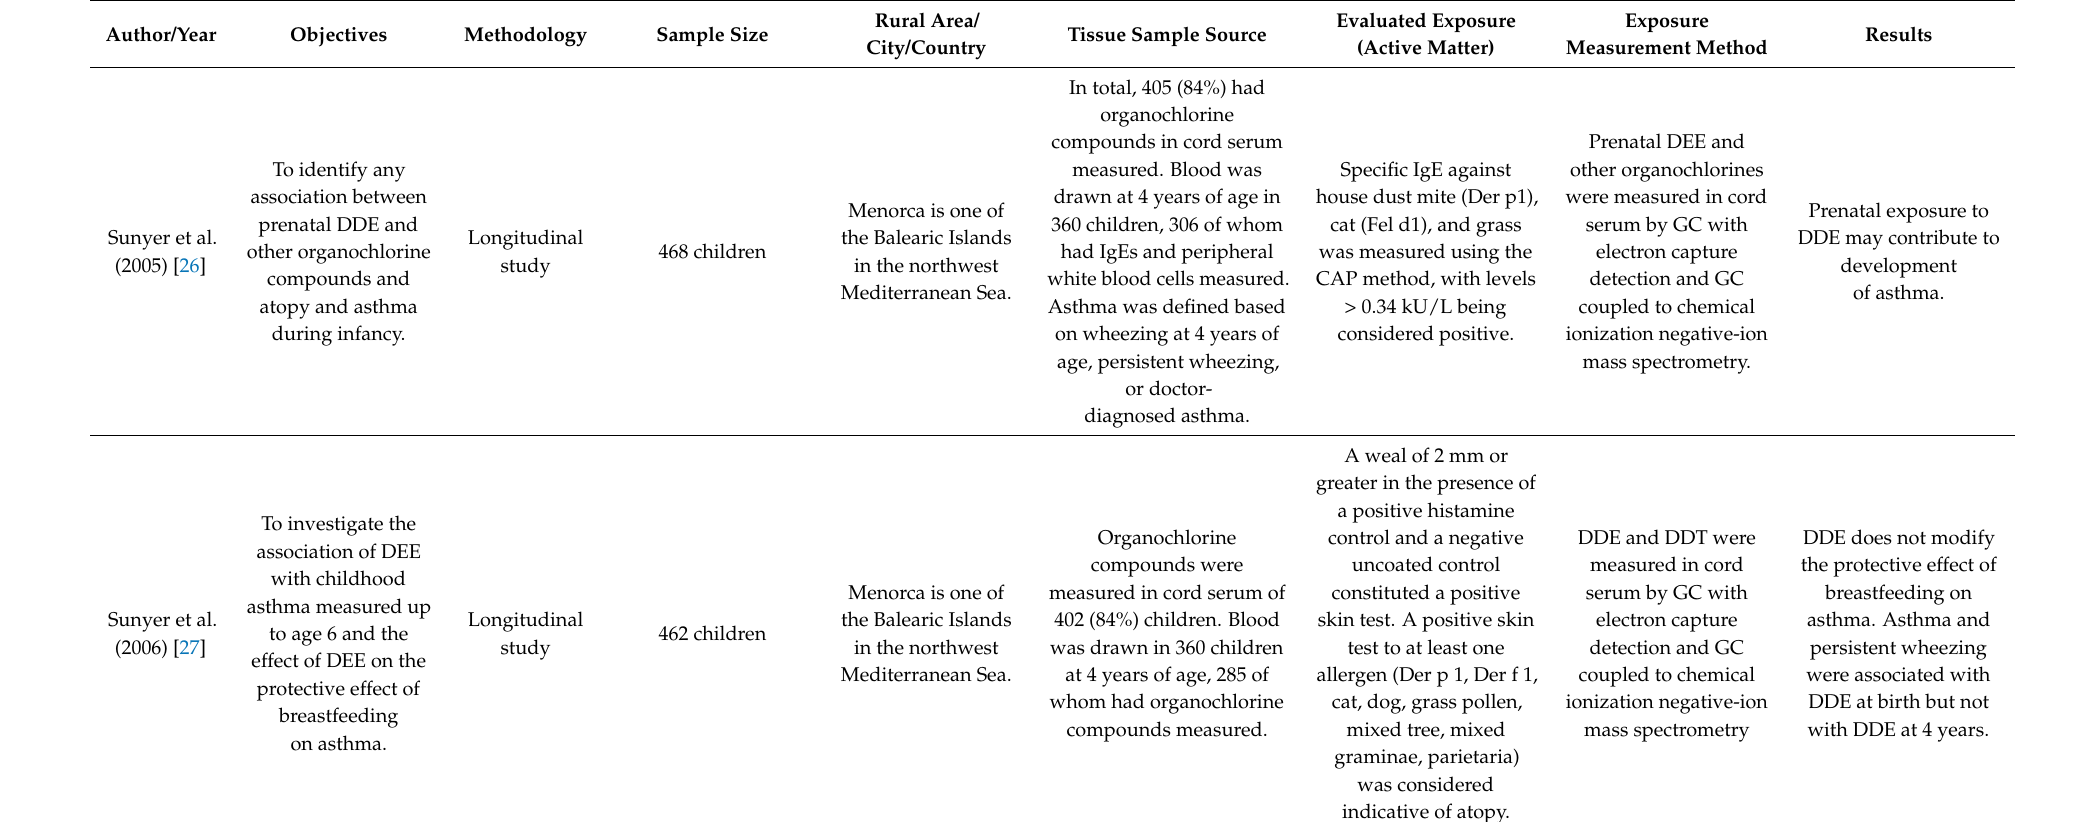
Table 1. Results of the articles included in the